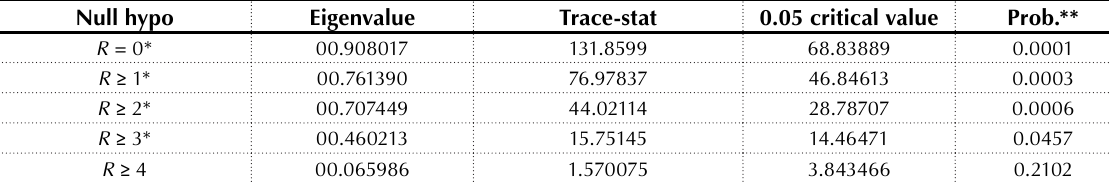
Table 3A. Trace test